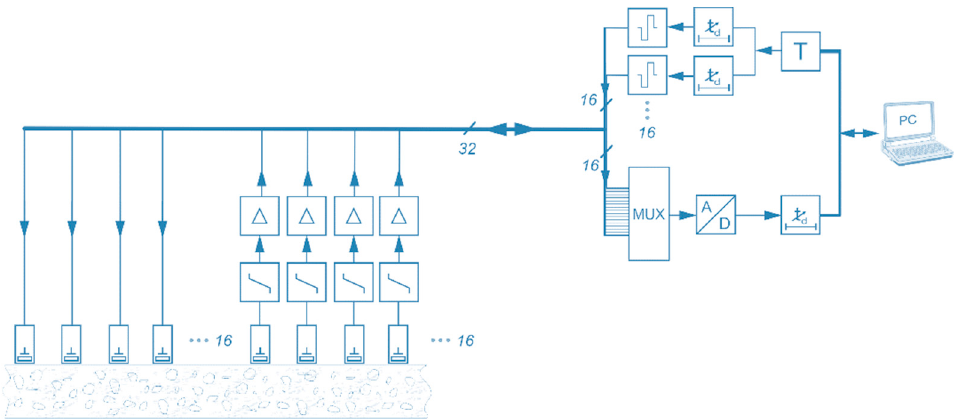
Figure 4. Schematic representation of phased array technique.